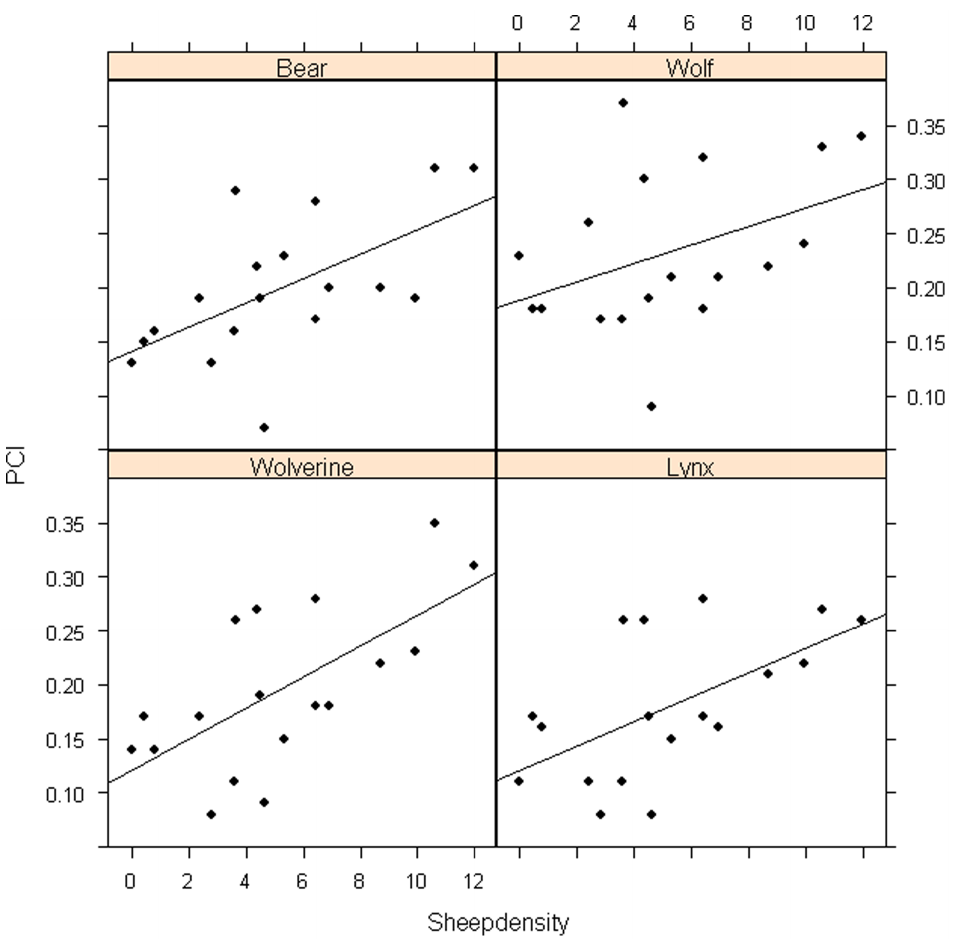
Figure 3. The correlation between potential conflict level (PCI 2 ) and free ranging sheep density (sheep pr. km 2 at county level; log transformed). PCI 2 estimated for each of the four carnivore species (PCI 6 Bear, PCI 7 Wolf, PCI 8 Wolverine, PCI 9 Lynx).